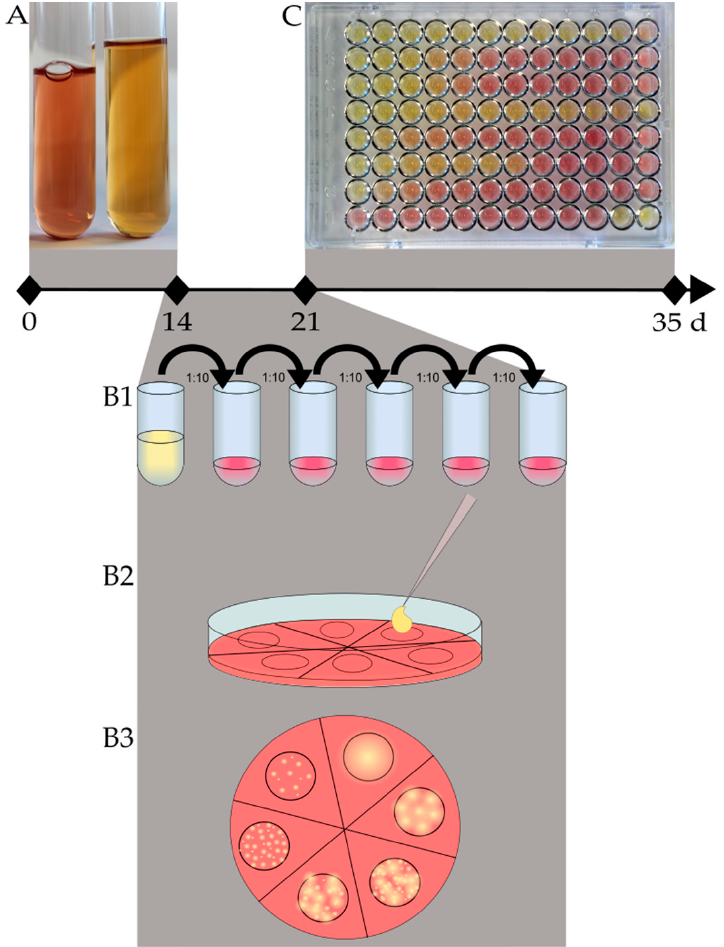
Figure 1. Schematic workflow and timeline for cultivation and antimicrobial susceptibility testing of M. hyorhinis . ( A ) According to CLSI, at least two subcultures of a properly grown culture are needed. Growth is characterized by a color change of the medium (pH shift) from red (no growth/growth control—left tube) to yellow (grown culture—right tube). ( B ) Cultures are serially diluted (tenfold) ( B1 ) over five steps; 20 µL of each dilution step, as well as the original culture, are dropped onto a Friis agar plate ( B2 ). The agar plate was divided into six sections. The area of the inoculum was encircled so that the area of growth can later be found easily. After incubation for up to 14 days, each section was evaluated for the presence of colonies using a stereo microscope. ( B3 ) Sections with 30 to 300 single colonies were used for calculating the CFU/mL ( C ) Depicted is an example of a microtiter plate after the maximum time of incubation (14 days), inoculated with the type strain M. hyorhinis DSM